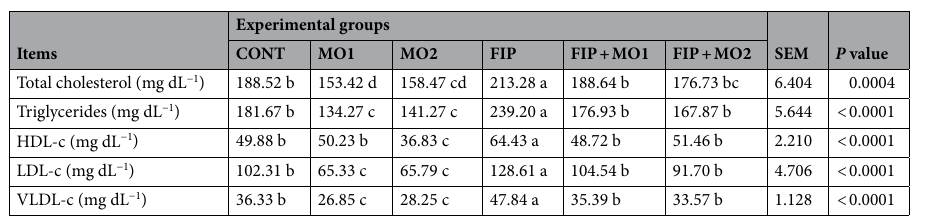
Table 5. Lipid profile of Nile tilapia groups during the present study. Data represent means ± S.E.M—means having different letters in the same row are significantly different at P < 0.05. HDL-c high density lipoprotein, LDL-c low density lipoprotein, VLDL-c very low-density lipoprotein.